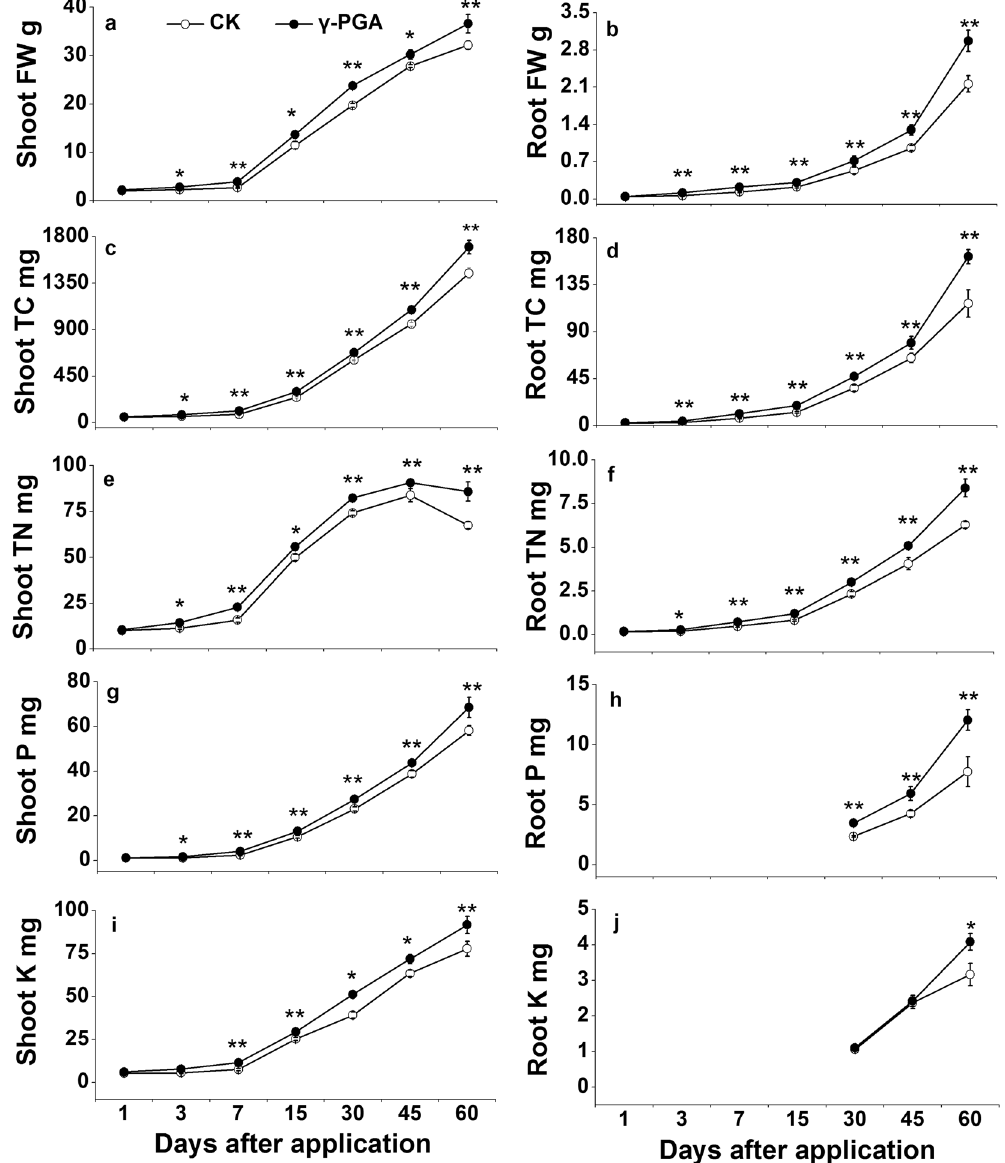
Figure 1. Temporal variations of fresh weight (FW, a , b ), total carbon (TC, c , d ), total nitrogen (TN, e , f ), total phosphorus (TP, g , h ) and total potassium (TK, i , j ) in the shoot and root tissues, respectively, of the Pakchoi. Error bars represent standard error (n = 3). CK: Normal fertilization with no γ -PGA application, γ -PGA: Normal fertilization with application of 350.44 mg γ -PGA kg − 1 soil. ** p < 0.01, * p <